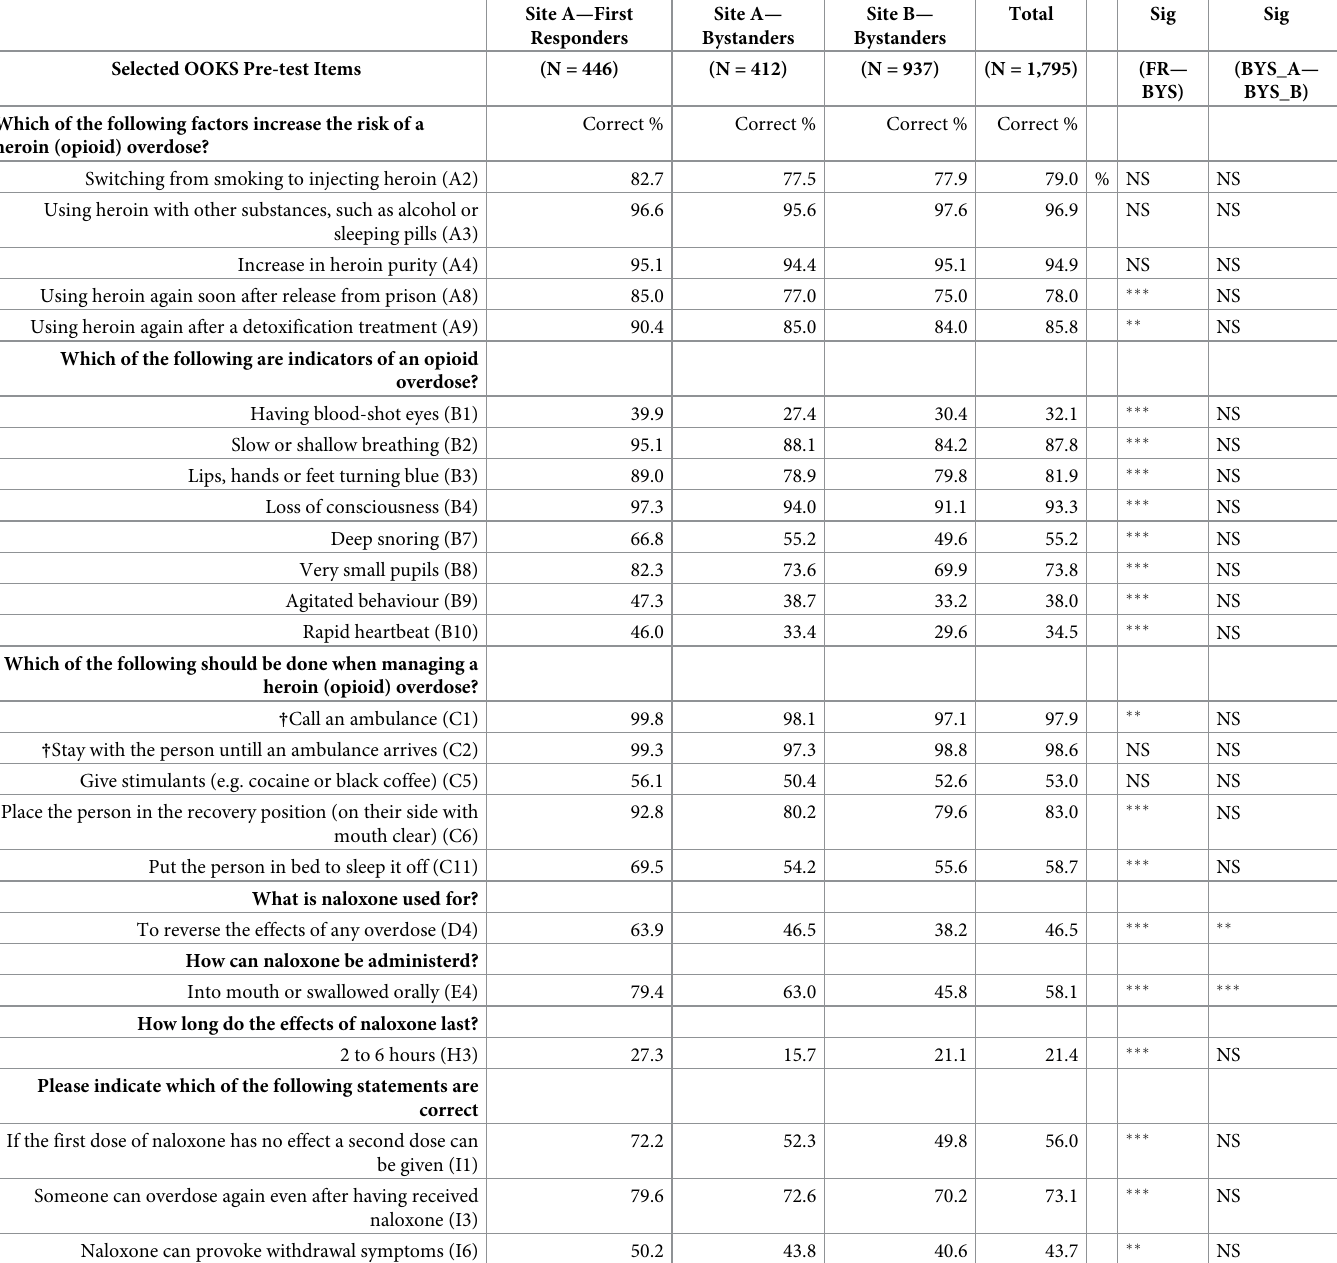
Site A—First Site A— Site B— Total Sig Sig Responders Bystanders Bystanders